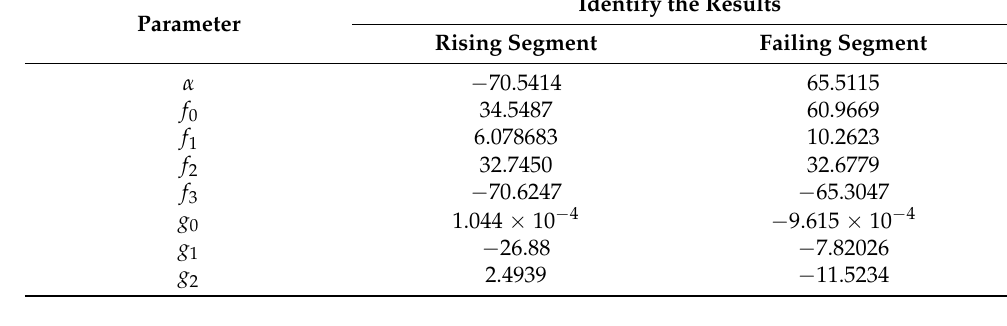
8 of 21 Figure 6. Fitting error plot between model data and experimental data: ( a ) fit plot; ( b ) error plot. It can be seen in Figure 6 that the data of the Duhem model established by the method of identifying the model parameters of the whole segment are poorly fitted with the data measured by the experiment, the maximum error of the output displacem ent is 3.122 μm, the mean square value of the displacement error of the whole curve reaches 0.784 μm, and the average fitting error is 0.89%.